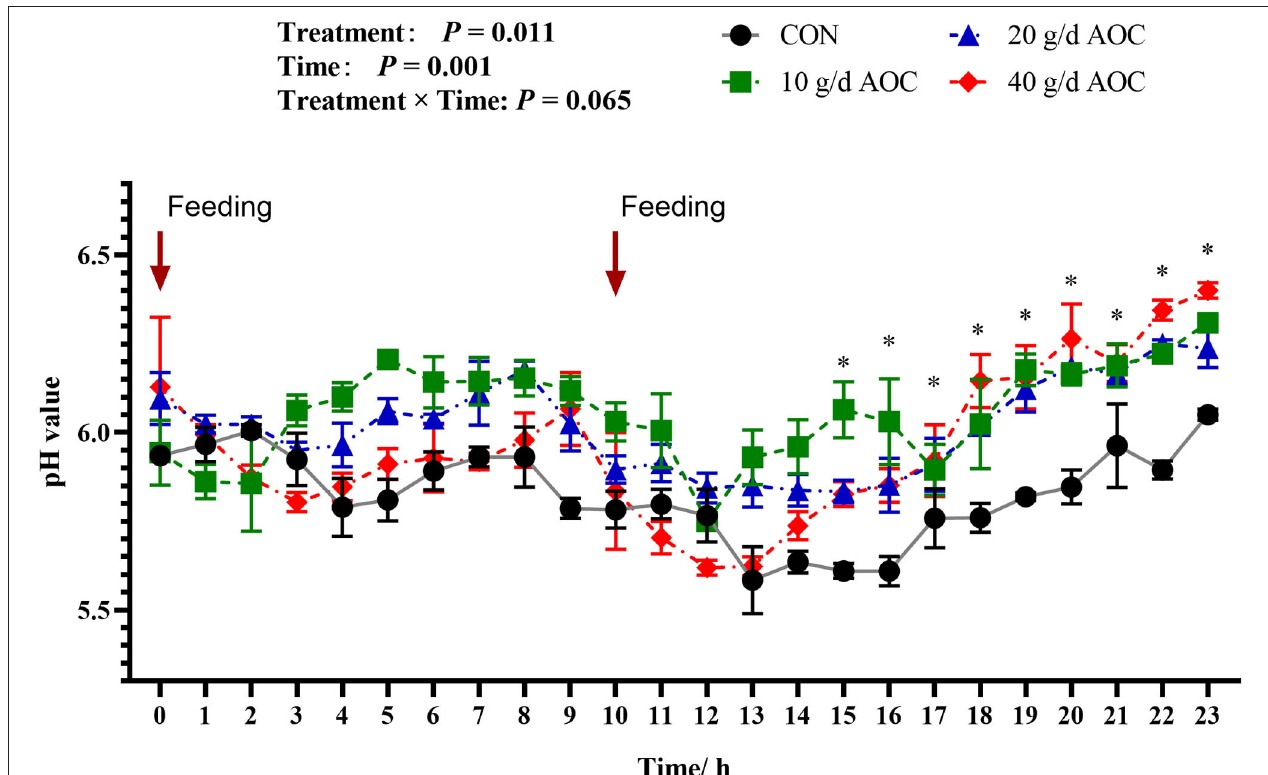
FIGURE 1 | Dynamic changes of ruminal pH of Hu sheep supplemented with different levels of Aspergillus oryzae culture. The arrows indicate the feeding time.